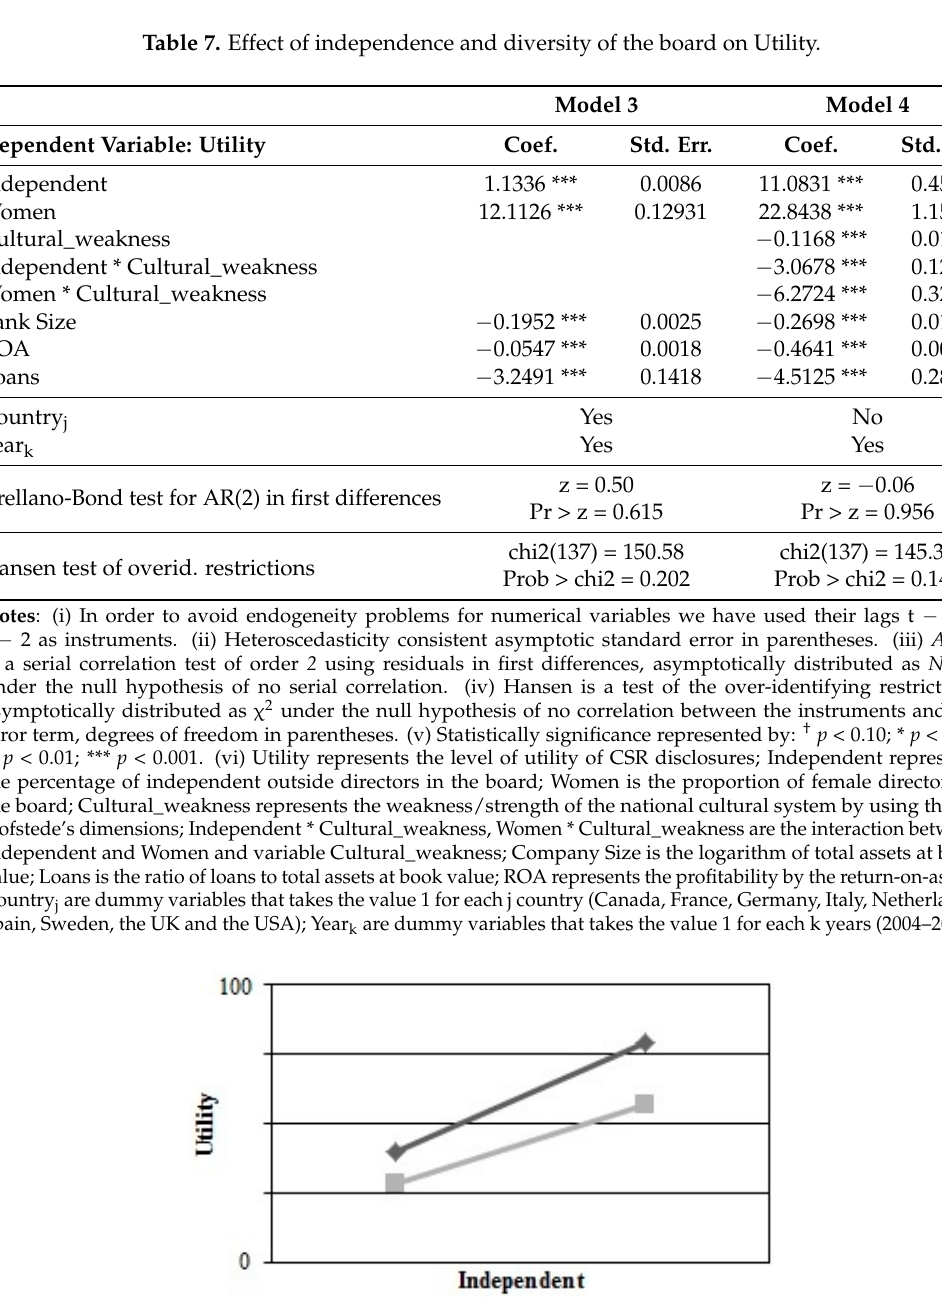
Table 7. Effect of independence and diversity of the board on Utility.